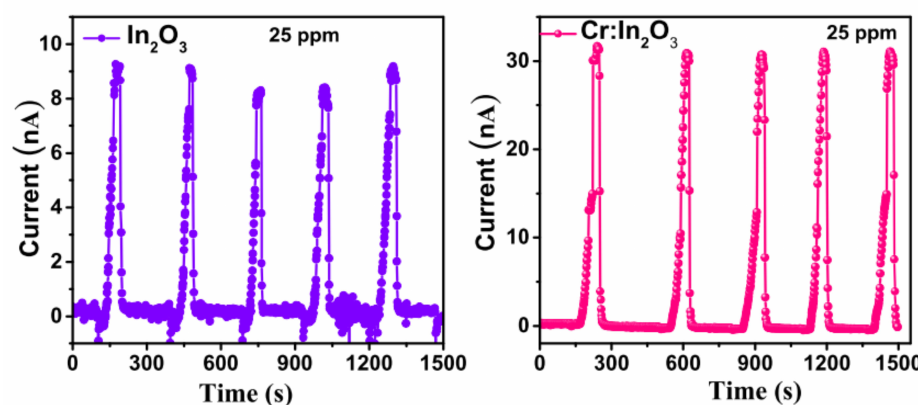
Figure 10. Repeatability for both pure In 2 O 3 and Cr doped In 2 O 3 thin films at 25 ppm of NH 3